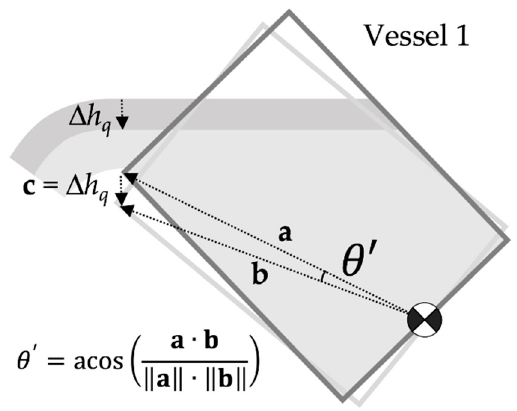
Figure 9. Vertical step of tilting in constant flow stage.